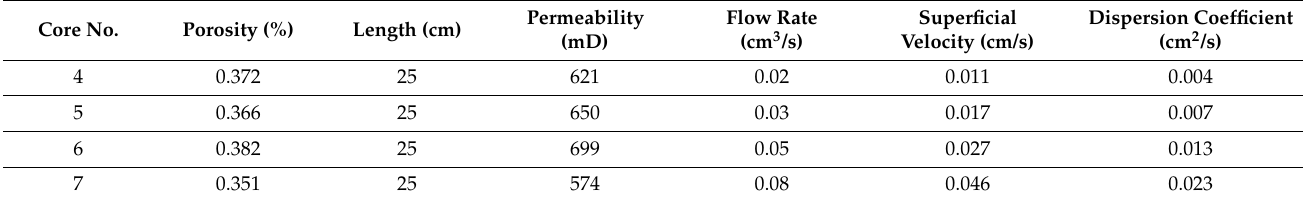
Table 4. Experimental parameters and fitted dispersion coefficient for the sand-filled cores. Core